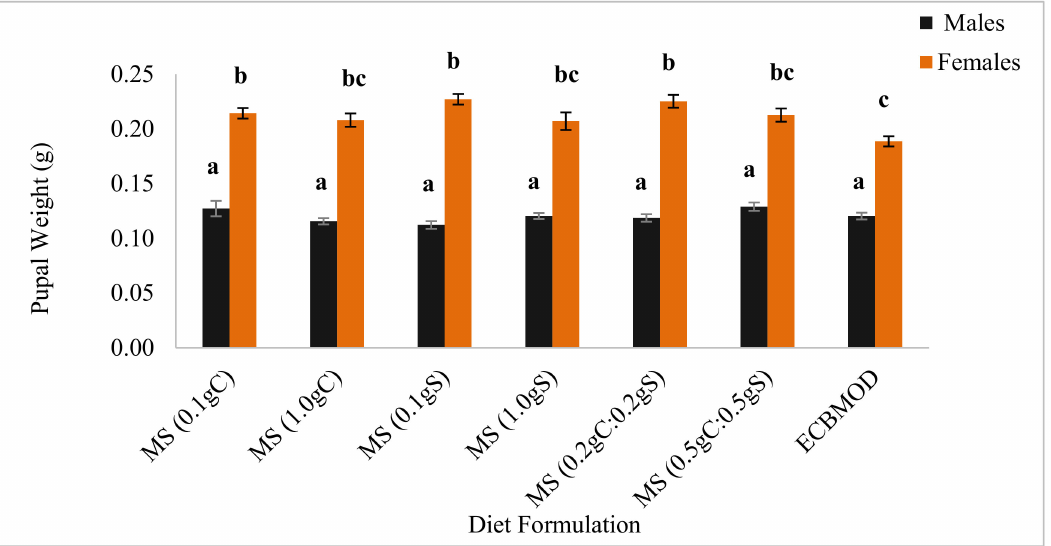
Figure 1. Mean ( ± SE) Eldana saccharina male and female pupal weights [ n = 30] at harvest (Day 27) for the MS (0.1 gC), MS (1.0 gC), MS (0.1 gS), MS (1.0 gS), MS (0.2 gC:0.2 gS), MS (0.5 gC:0.5 gS) and ECBMOD control diets. Different lower-case letters above the graph histogram bars indicate that mean differences are significant at the 0.05